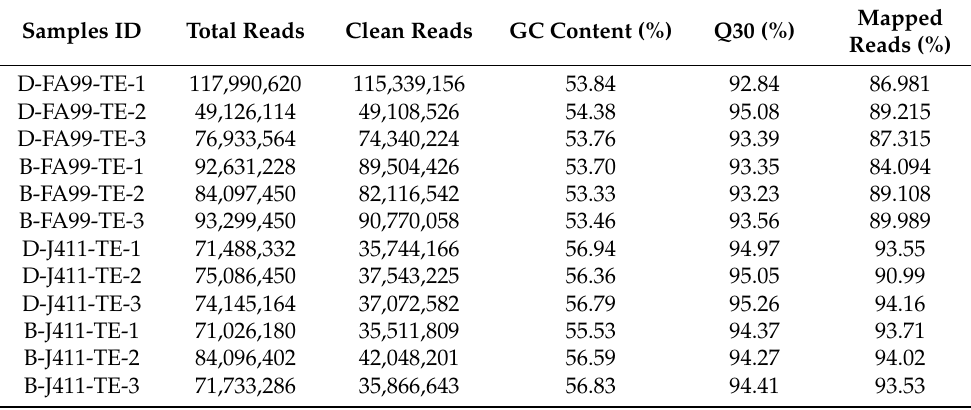
Table 3. Summary and evaluation of transcriptome-sequencing